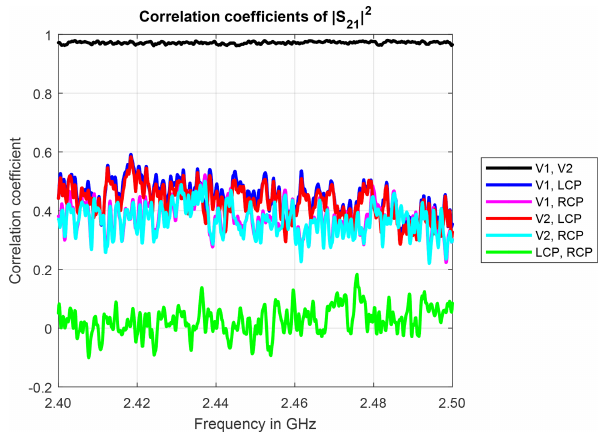
Figure 10. Average transmission for different antennas and mea- surement trial 4.